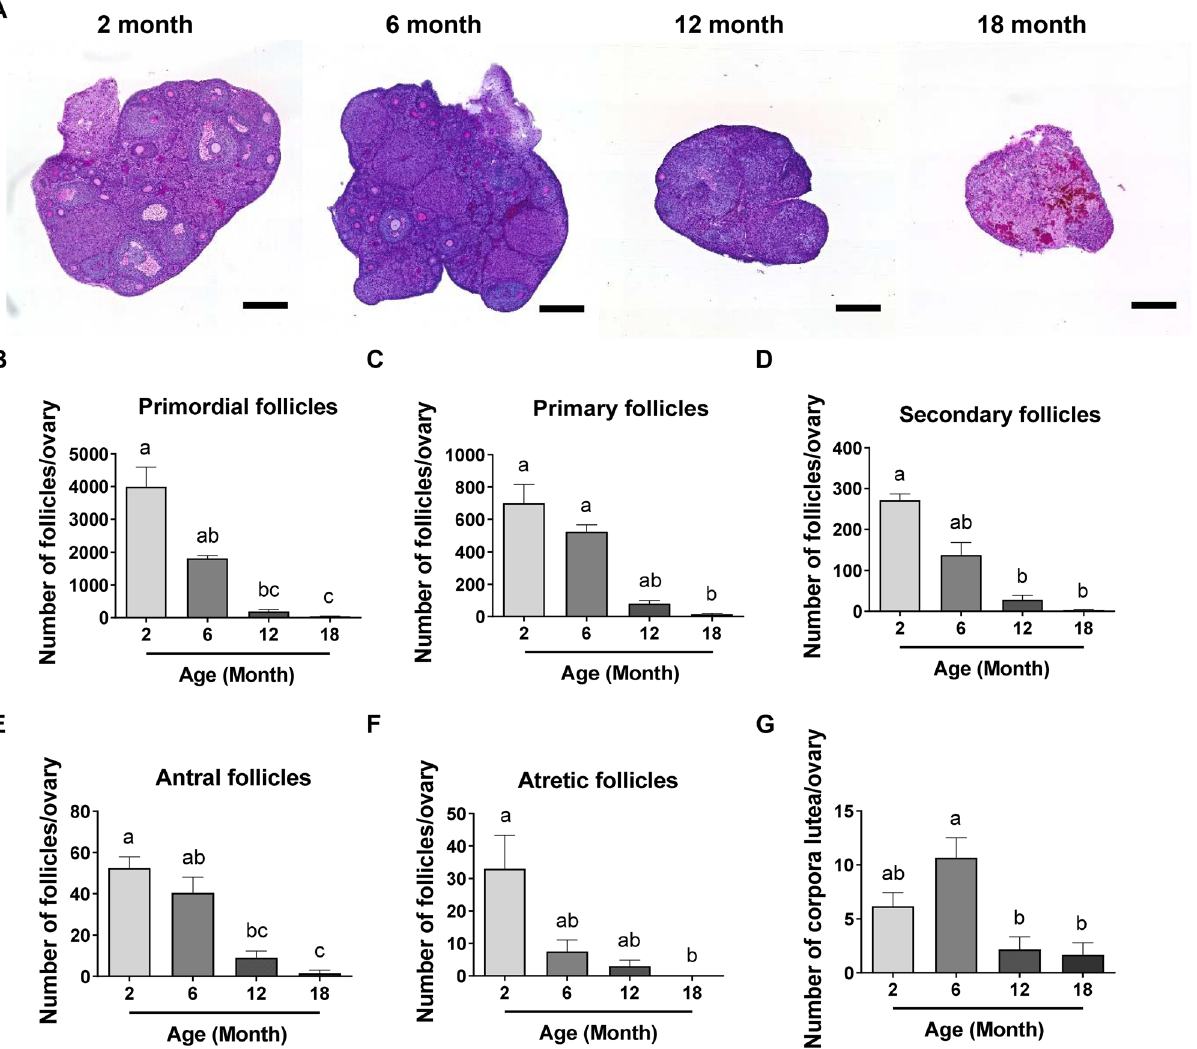
Figure 1. Reproductive ageing is associated with a progressive loss of follicle and corpora lutea numbers in the mouse ovary. ( A ) Representative images of PAS-stained ovarian sections from 2, 6, 12 and 18-month-old mice visualized by bright-field microscopy. Scale bars are 400 μm. Primordial ( B ), primary ( C ), secondary ( D ), antral ( E ), atretic follicle ( F ) and corpora lutea ( G ) numbers in ovaries from 2, 6, 12 and 18-month-old mice. n = 6 per cohort. Data are presented as mean ± SEM; Kruskal–Wallis test, Dunn’s multiple comparisons test: a, b and c are significantly different among groups ( p < 0.05); Ordinary One-way ANOVA, Tukey’s multiple comparisons test: a, b and c are significantly different among groups ( p <